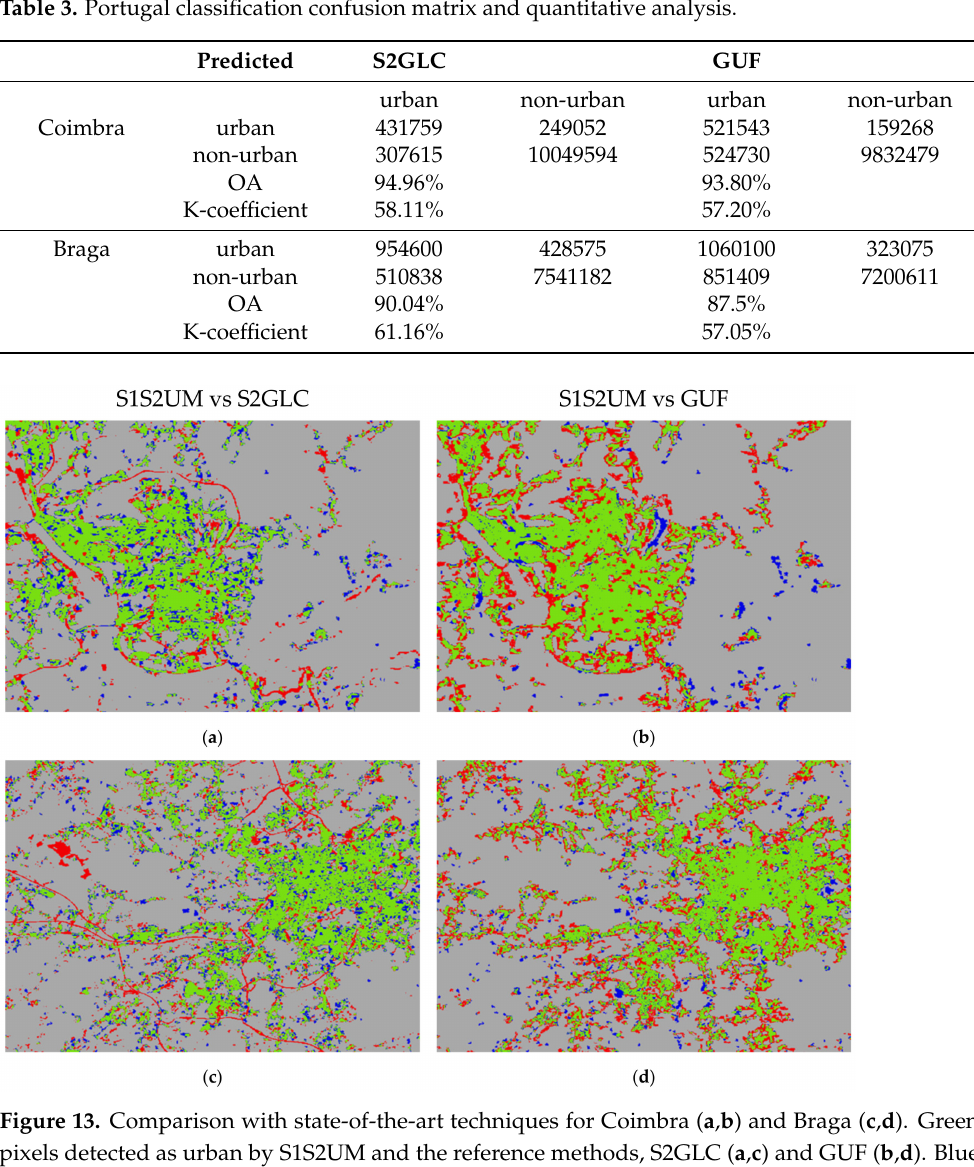
Table 3. Portugal classification confusion matrix and quantitative analysis.